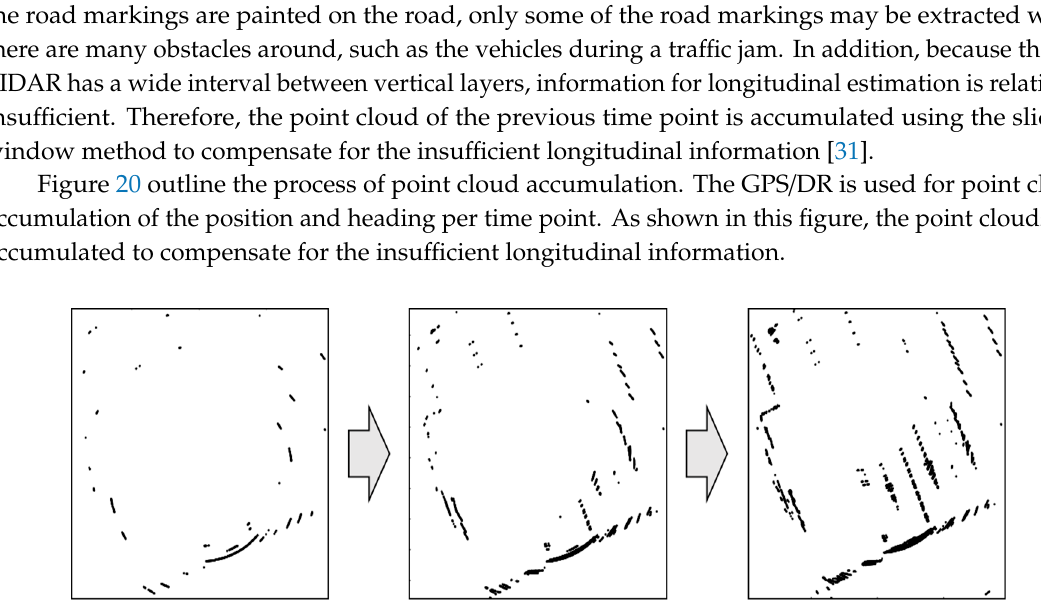
Figure 20. Process of point cloud accumulation.